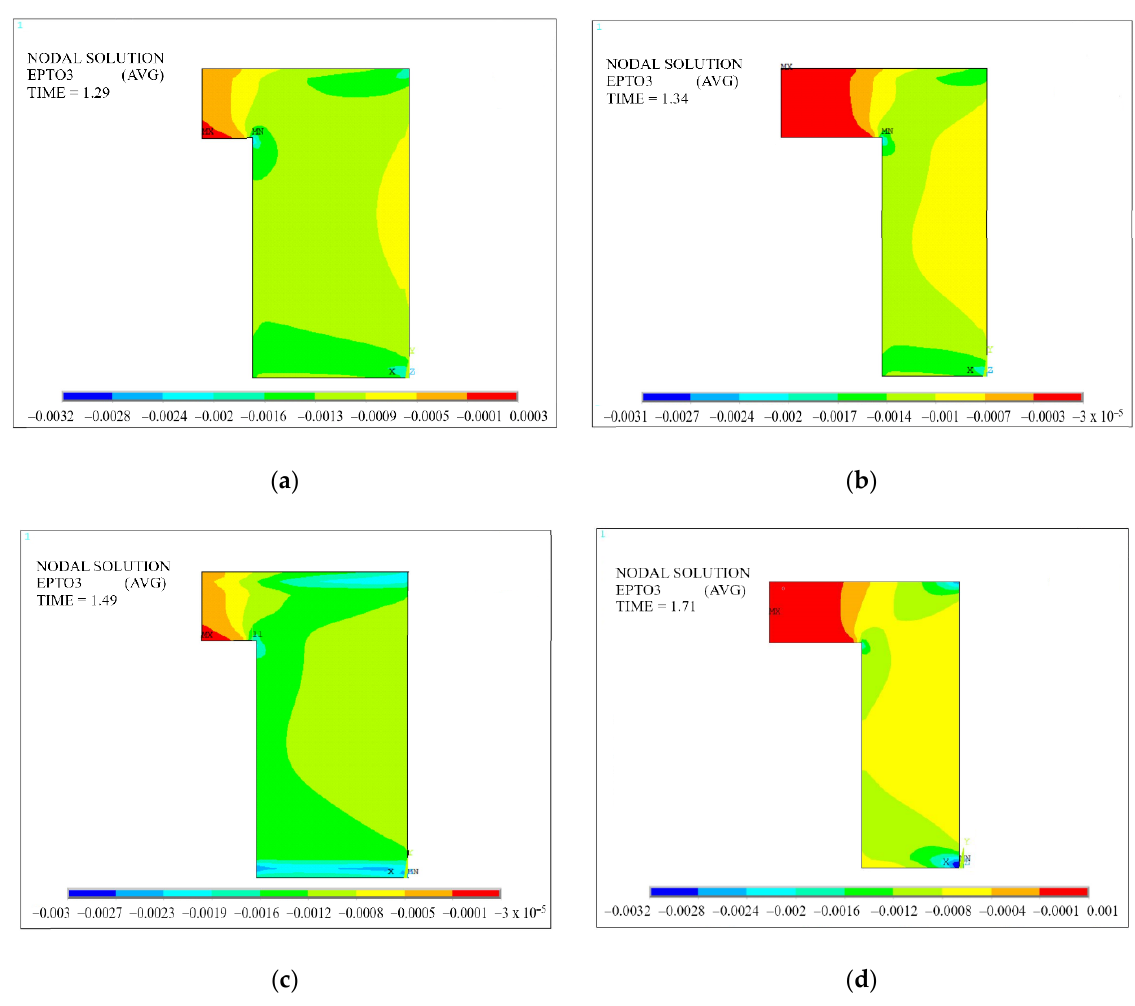
Figure 8. Concrete principal strain distribution: ( a ) CD-20; ( b ) CD-39; ( c ) SD-20; ( d ) SD-39.